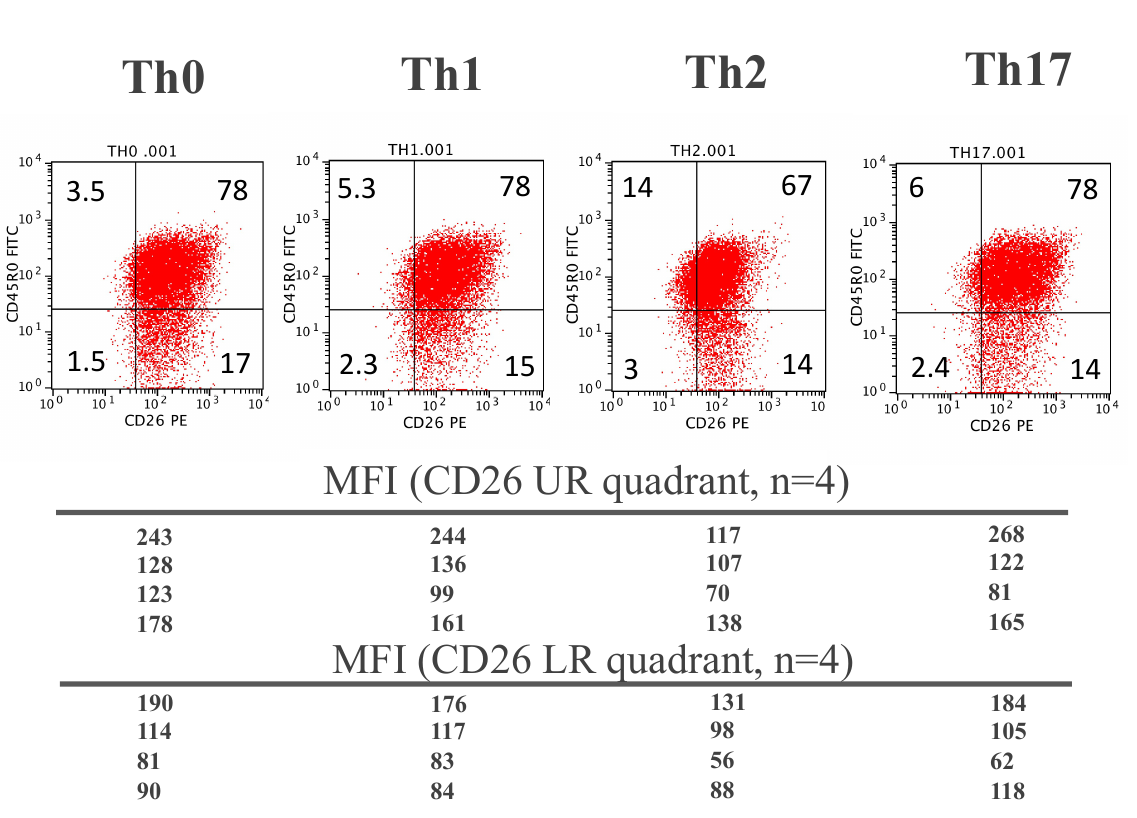
Figure 6. Cell surface CD45R0 and CD26 staining in CD4 T cells activated in-vitro from naïve cells under different polarization conditions (controls are shown in Supplemental Figure S6): Th0 (no polarization), Th1, Th2 and Th17. Numbers in each quadrant correspond to the respective percentages. The dot plots are representative from one out of 4 different experiments. For comparison, MFI data from CD26 staining are shown in the bottom for each condition (as the range of intensities from one experiment to another was somewhat high, the means were not